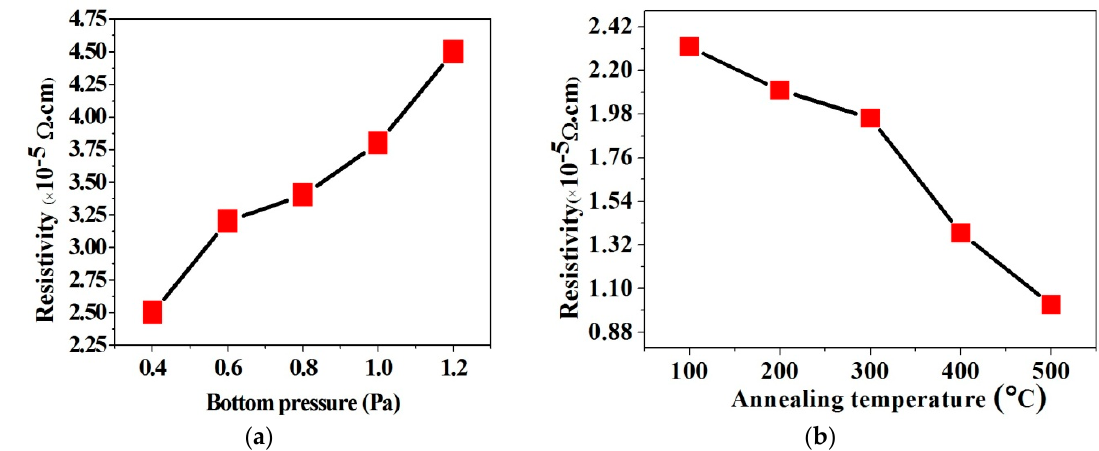
Figure 4. Resistivity of Mo bilayer films deposited at different bottom sputtering pressures ( a ) and annealed at different temperatures ( b ).